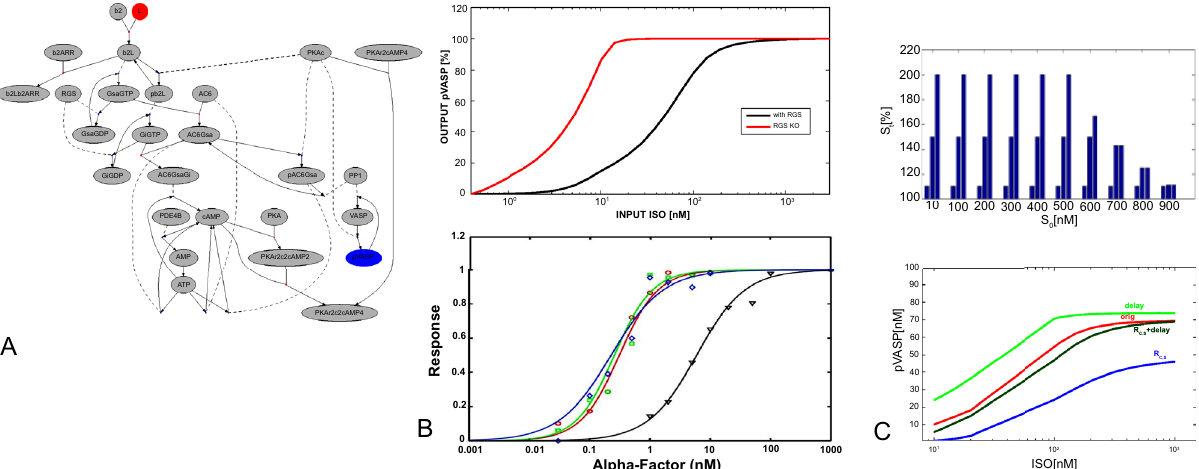
Figure 1. A . Biochemical Reaction System with Selected Input (red) and Output (blue) B . (Top) ISO-pVASP transfer function (with RGS KO, red) in the MEF model 11 (Bottom) Experimental Response to RGS KO for GPCR signal-response in a yeast model 10 C. (Top) Distribution of Extracellular Signals Used to Calculate Signal Transmission. From a baseline signal S to 110%,150% and 200%, but not above 1 m M. (Bottom) Transfer Functions for ISO → pVASP. Shown is the original model, optimization by delay, by R C,S , and by